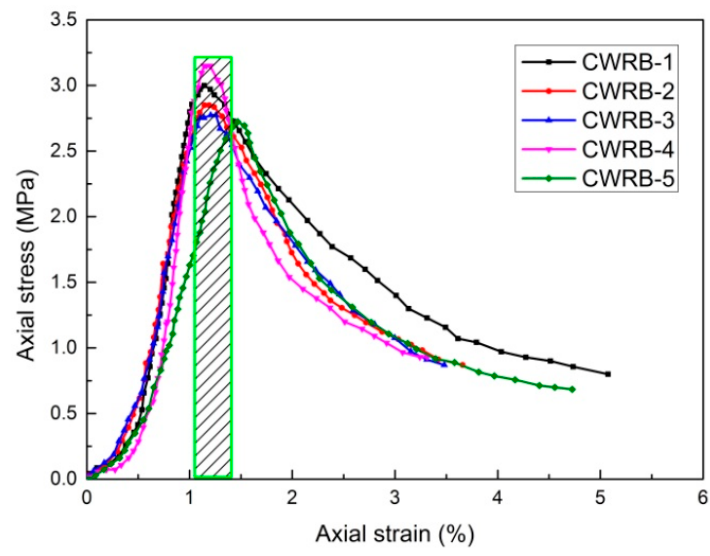
Figure 6. The macroscopic stress strain curves of CWRB sample 1–5, obtained by the GCTS RTR-2000 rock mechanics apparatus (GCTS, Tempe, AZ, USA).